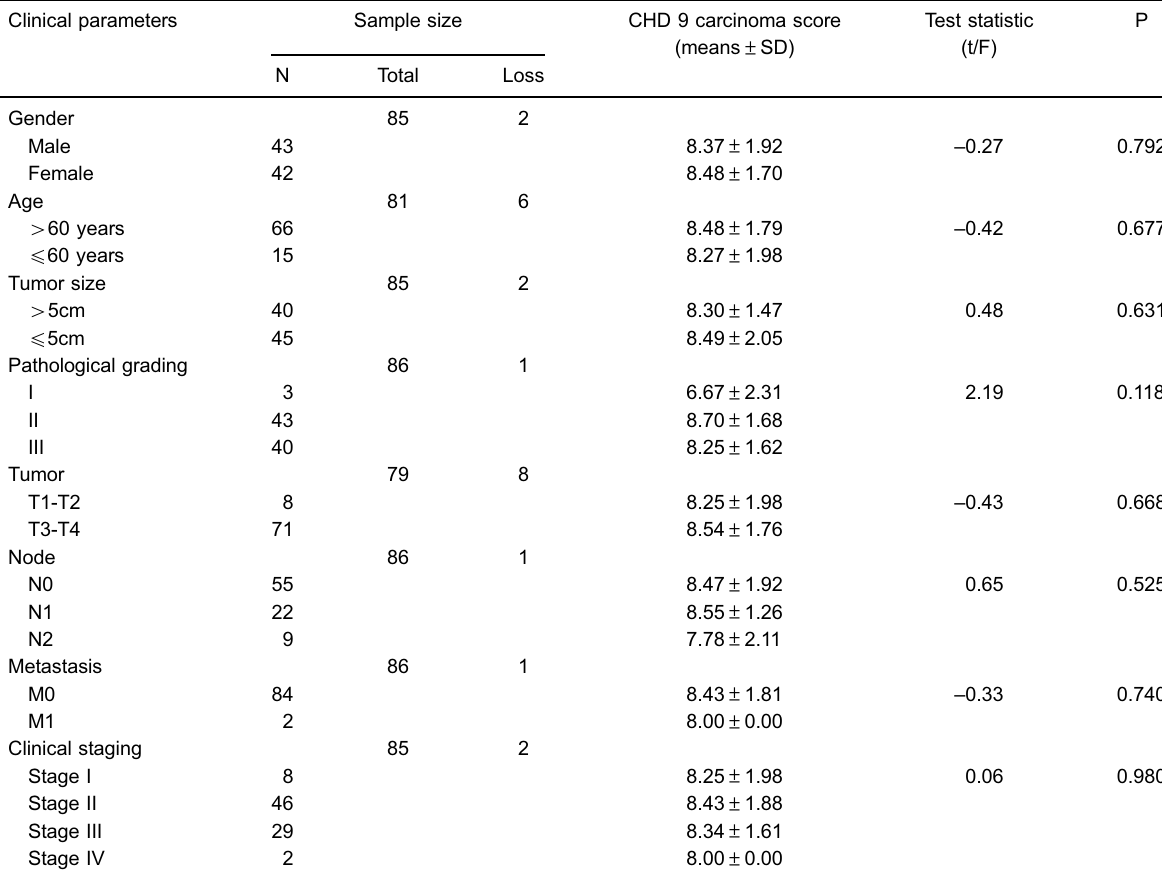
Table 1. Correlation between clinical data and CHD 9 expression in colorectal cancer. Clinical